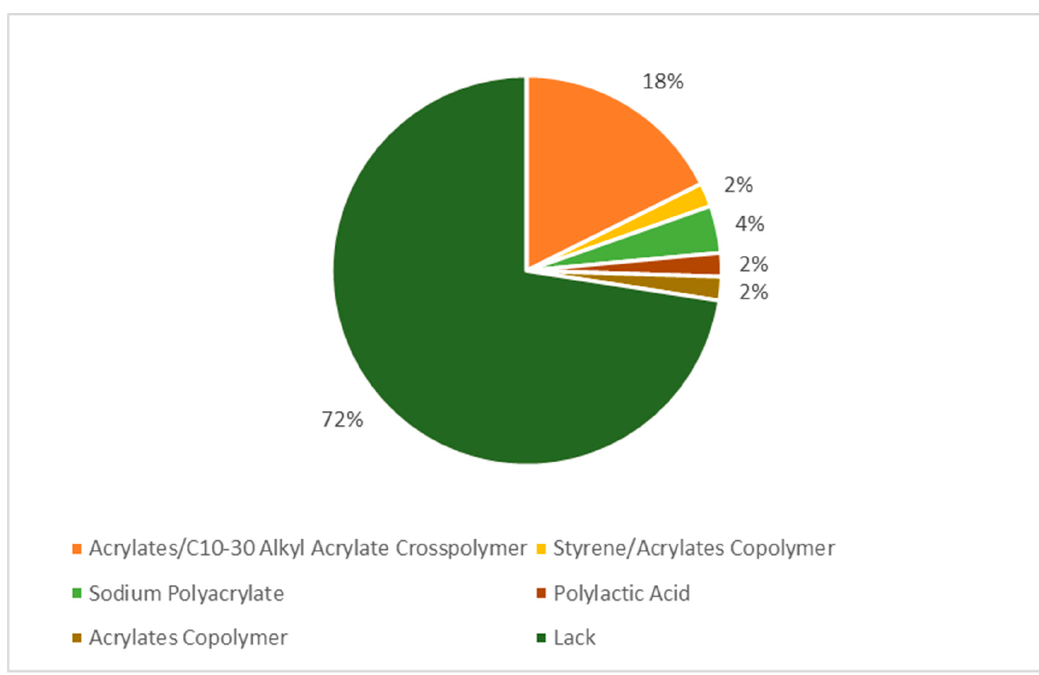
Figure 1. The percentage of microplastic content in the 50 cosmetic products analyzed.